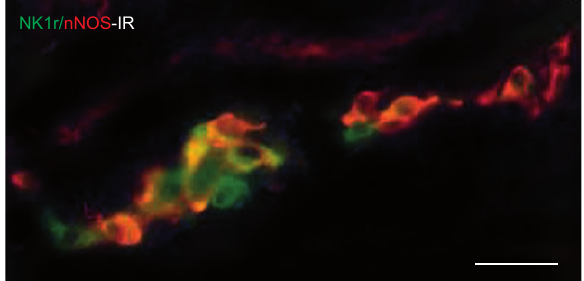
Figure 1 Mouse stomach. Double labeling with NK1r and nNOS antibodies. In a myenteric ganglion, some neurons are NK1r-IR (in green), some are nNOS-IR (in red), and some others are NK1r/nNOS-IR (in orange). Calibration bar, 40 μ m [From Ref. (30) with